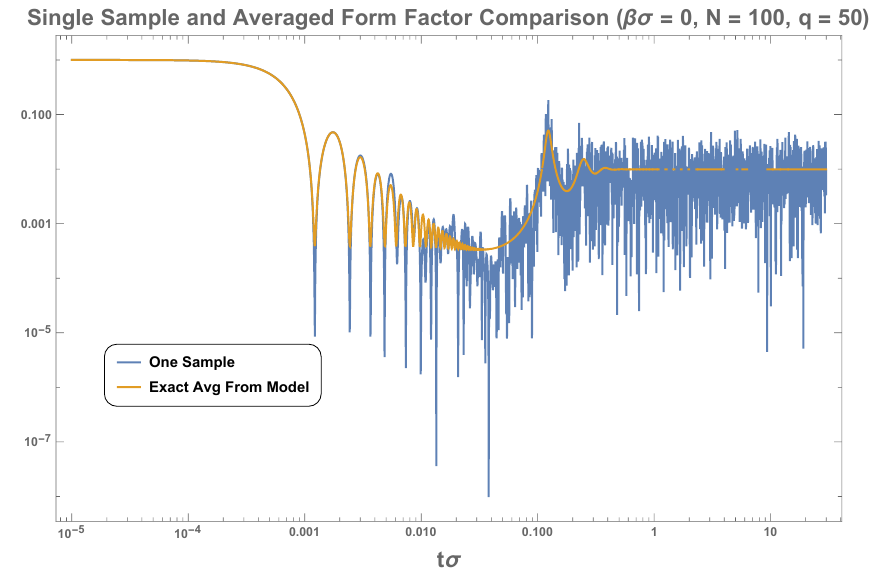
Figure 11 . Above is a Log-Log plot that compares the spectral form factor of a single sample (blue curve), and the averaged form factor (yellow curve) from the i.i.d model with gamma distribution spacing defined in eq. (3.15), with q = 50 , N = 100 , and βσ = 0